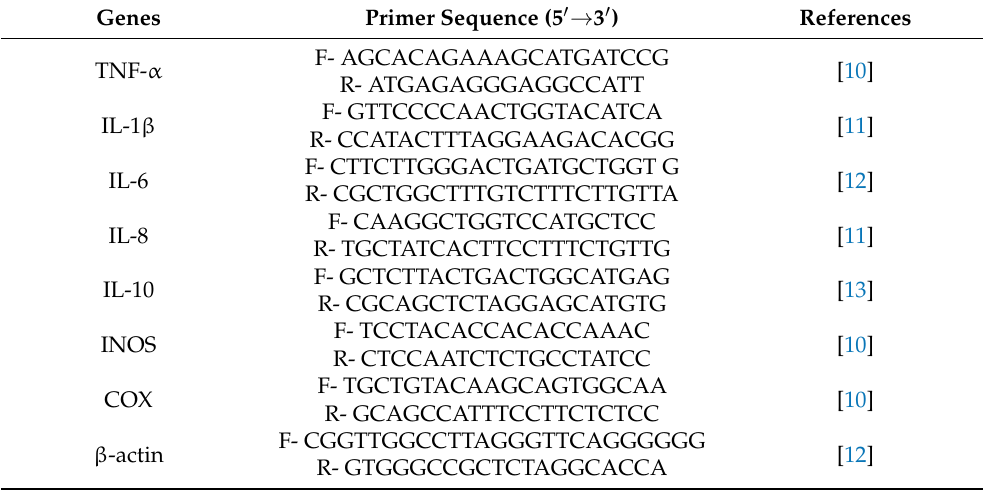
Table 1. Primers used for qRT-PCR. Genes Primer Sequence (5 (cid:48) → 3 (cid:48)